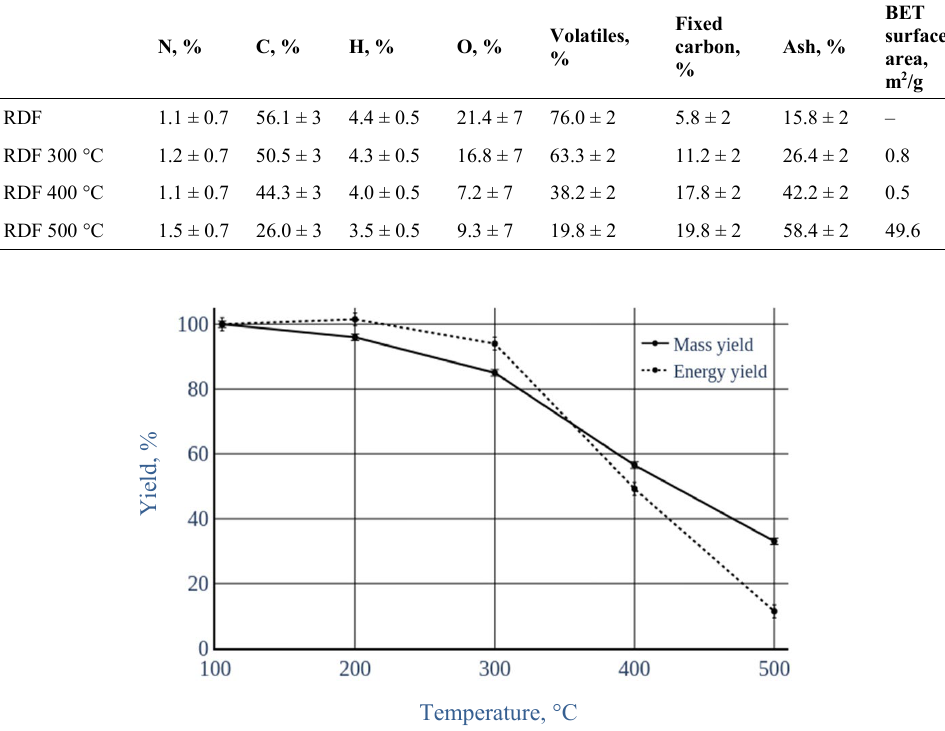
Fig. 2. Mass and energy yields in solid residue as a result of treatment at different